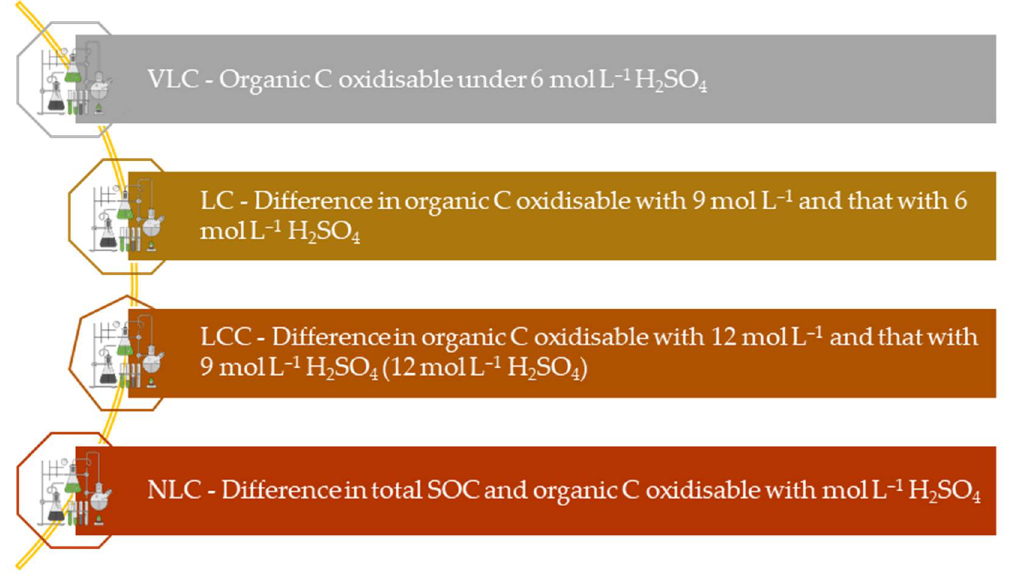
Figure 3. Systematic representation of soil carbon fractions of varying oxidizability.